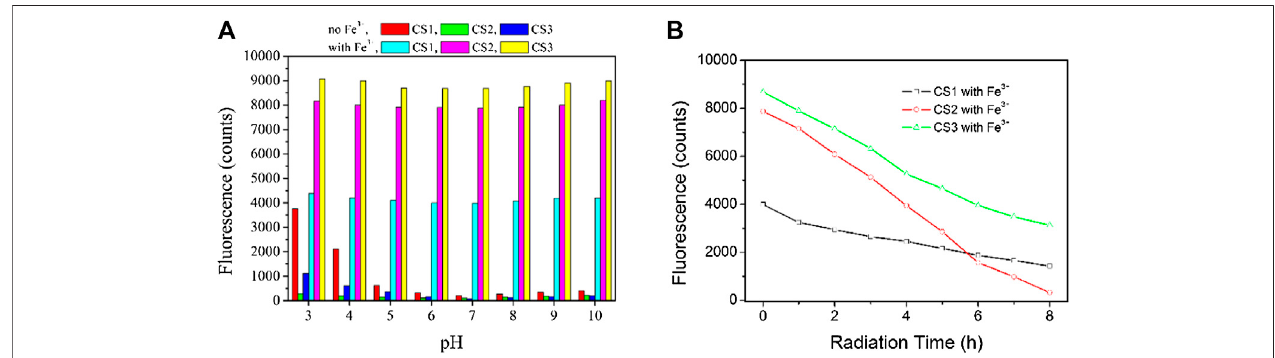
FIGURE6|(A) Emissionintensityvariationofthesechemosensors(10 μ M)uponvariouspHvalues,withoutandwithFe 3+ (5.0equiv)intheaqueous(containing5% ethanolasaco-solvent). (B) emissionintensitymonitoringofthesechemosensors(10 μ M)uponcontinuousradiation,withFe 3+ (5.0equiv)intheaqueous(containing5% ethanol as a co-solvent), excitation wavelength = 550 nm.